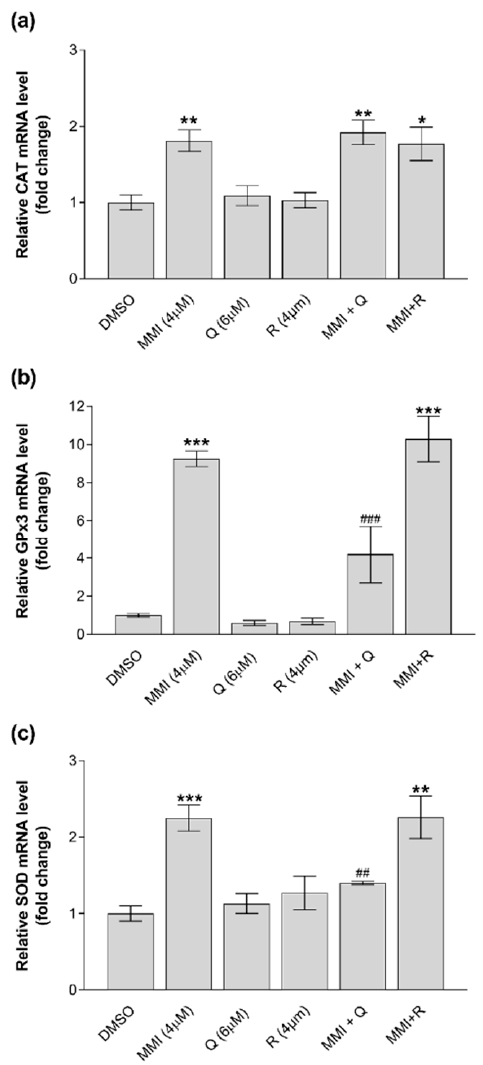
Figure 4. Gene expression modulation in CRFK cells treated with MMI (4 µ M), Q (6 µ M), or R (4 µ M) or co-exposed to MMI (4 µ M) + Q (6 µ M), and MMI (4 µ M) + R (4 µ M) for 24 h. The mRNA expression levels of CAT ( a ), GPx3 ( b ) and SOD ( c ) were determined by quantitative RT-PCR. Results are expressed as a fold change compared with the solvent control (0.1% DMSO). Data are represented as mean ± SEM of three independent experiments and analyzed by one-way ANOVA followed by Sidak’s test. Statistical differences with respect to the controls (* p < 0.05, ** p < 0.01, *** p < 0.0001) and with respect to the cells treated with MMI alone ( ## p < 0.01, ### p < 0.001) are